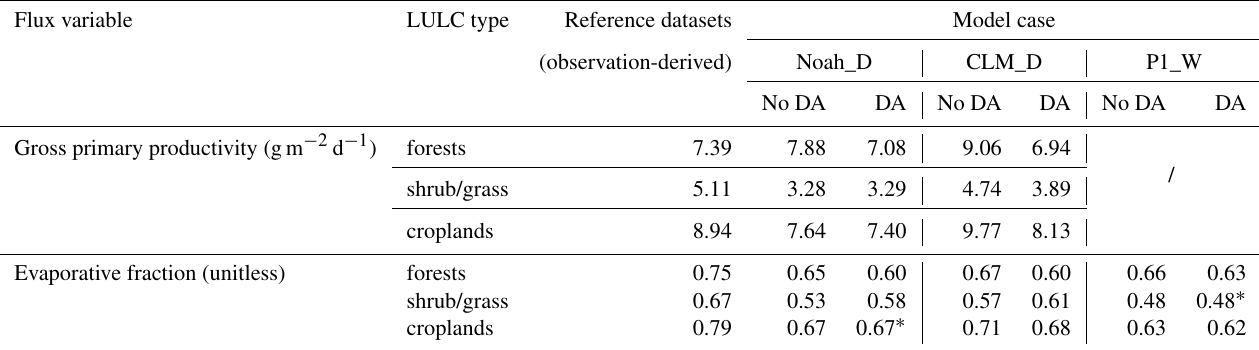
Table 4. Evaluation of daily-averaged WRF-Chem gross primary productivity and evaporative fraction, referring to the SMAP L4C and FLUXCOM datasets.